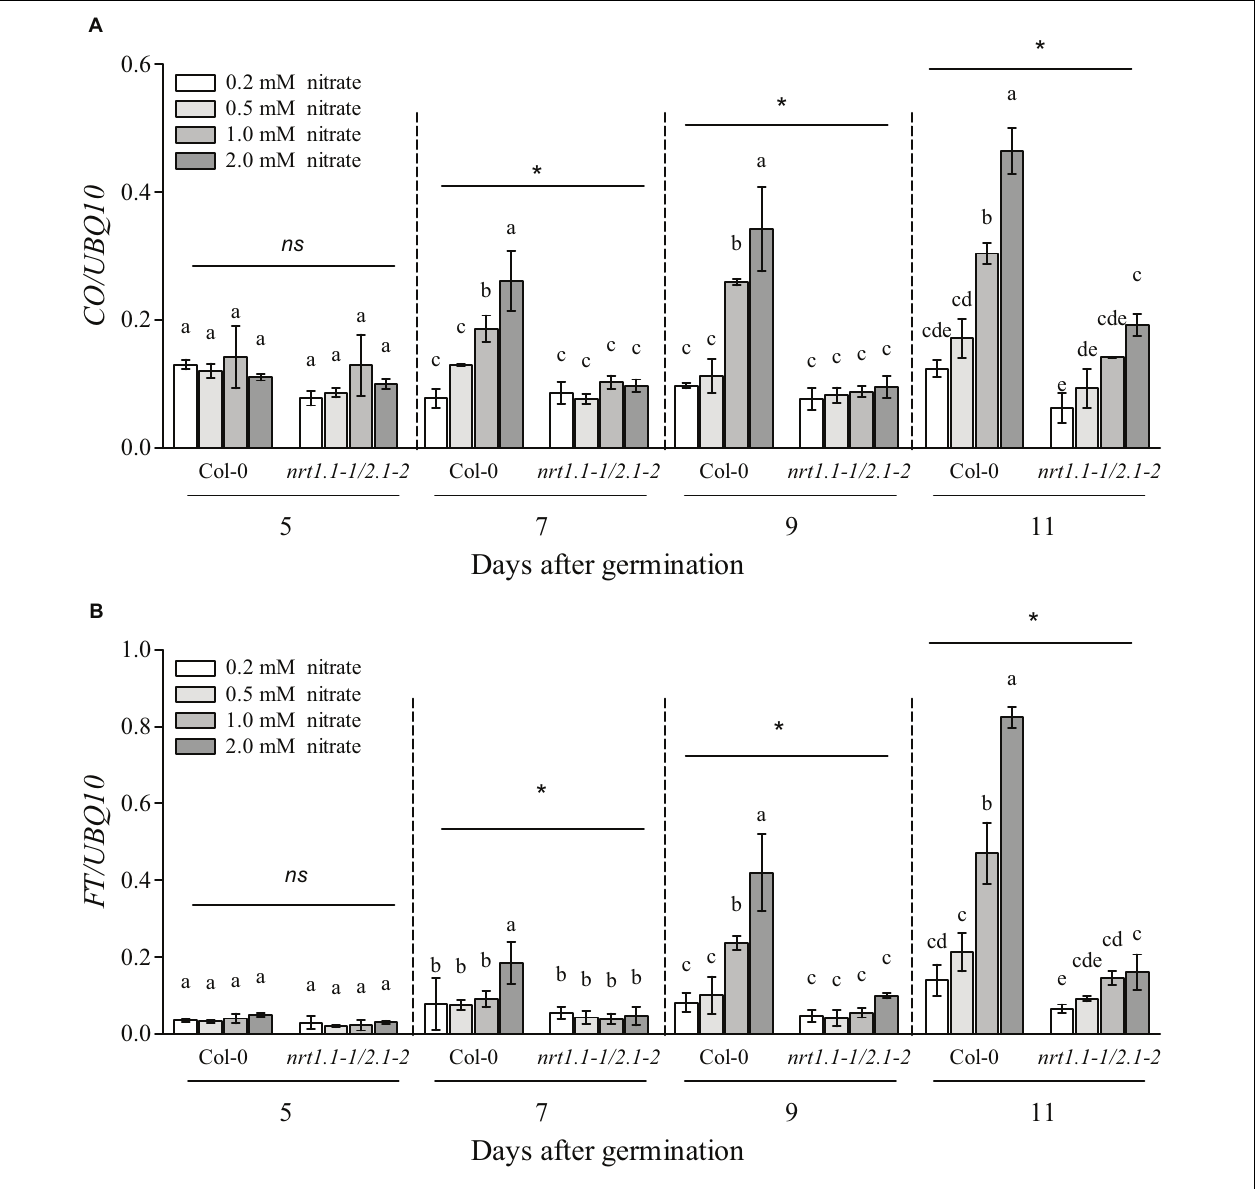
FIGURE 7 | Loss of function of NRT1.1 and NRT2.1 suppressed the induction of FT and CO by increasing nitrate supplies under LD conditions. Temporal expression of CO (A) and FT (B) in the shoots of Col-0 and nrt1.1-1/2.1-2 plants grown in 0.2, 0.5, 1.0, and 2.0 mM nitrate treatments, under LD conditions. Plants were harvested at zeitgeber time (ZT) 16 h for RNA extraction, after the indicated number of germination days. Potassium concentrations in all growth media were adjusted to 2 mM using K 2 SO 4 . Expression levels are normalized to the expression level of UBIQUITIN 10 . Bars represent means ± standard deviations ( n = 4). Different letters indicate significant differences between the means, as determined using a two-way ANOVA followed by Tukey’s multiple comparisons test ( P < 0.05). Significant interactions between photoperiod and genotype are indicated by an asterisk (* P < 0.05; ns,